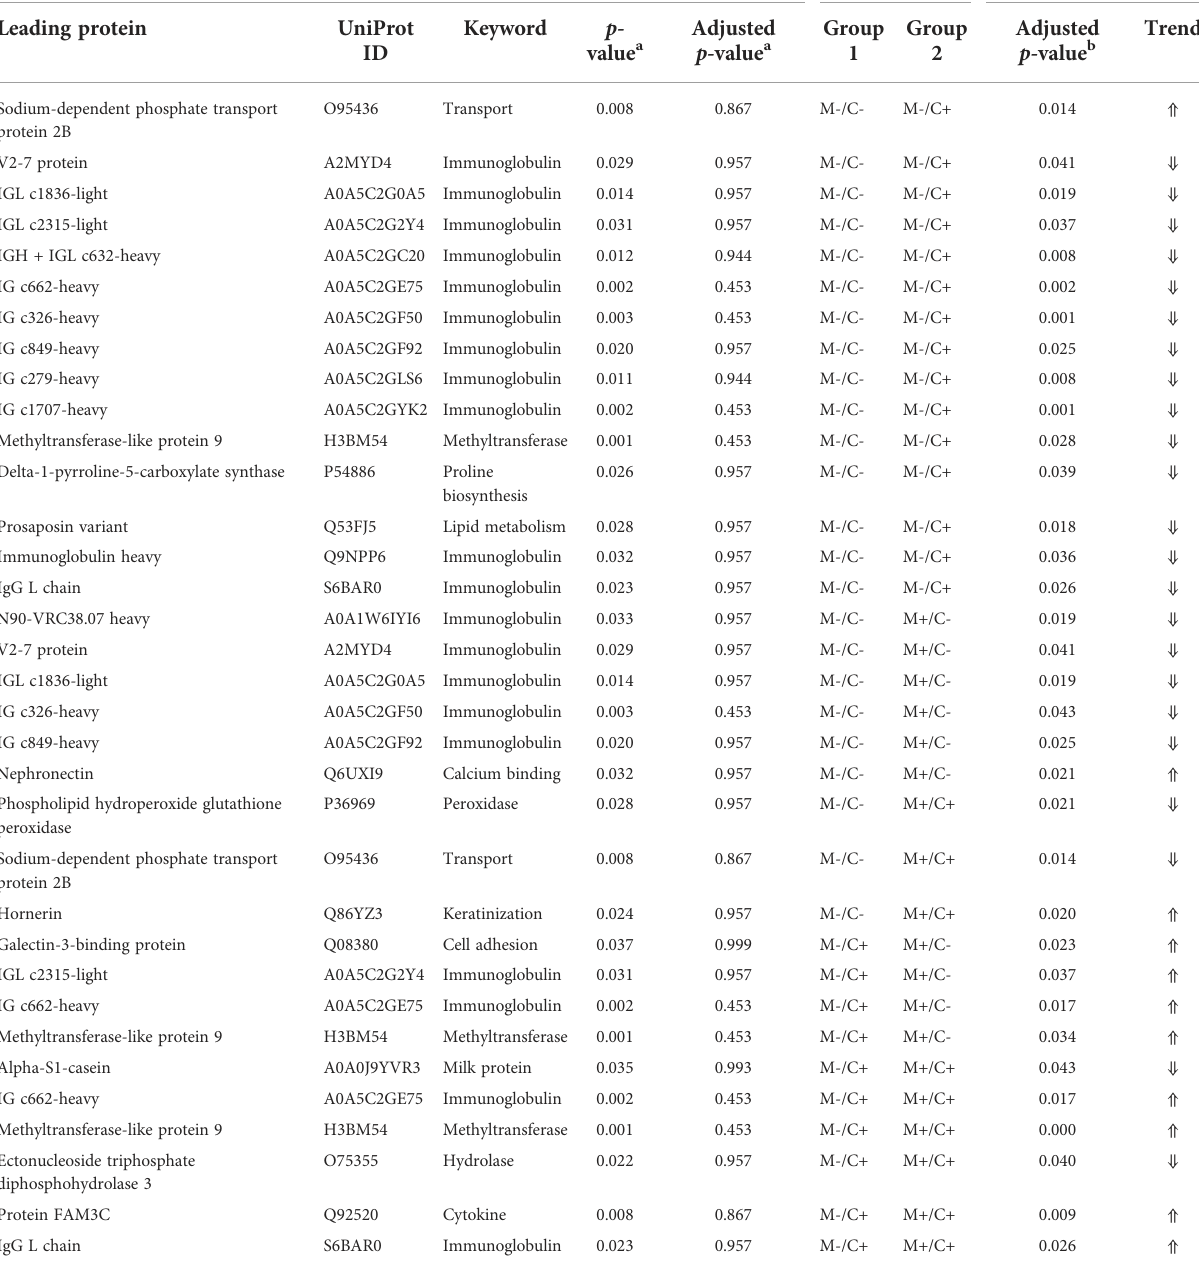
TABLE 1 Results of univariate analysis (Kruskal-Wallis) with subsequent post-hoc test (Dunn ’ s) for the comparison of protein abundance in milk from allergic (M+) and non-allergic (M-) mothers, with children who developed an allergy (C+) and did not develop an allergy (C-) in the CHILD Cohort